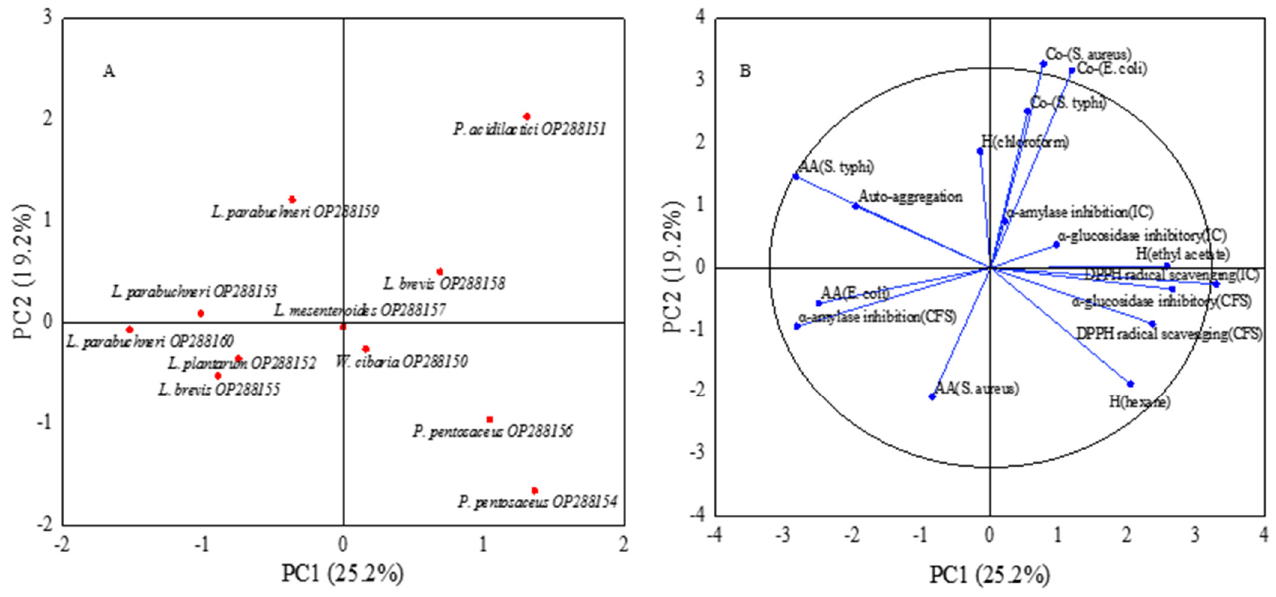
Figure 4. Principal component analysis (PCA) of 11 LAB strains and probiotic properties: ( A ) Projection of the LAB strains in the space of PC1 and PC2; ( B ) Projection of the probiotic properties on the plane formed by PC1 and PC2 analyzed by PCA.